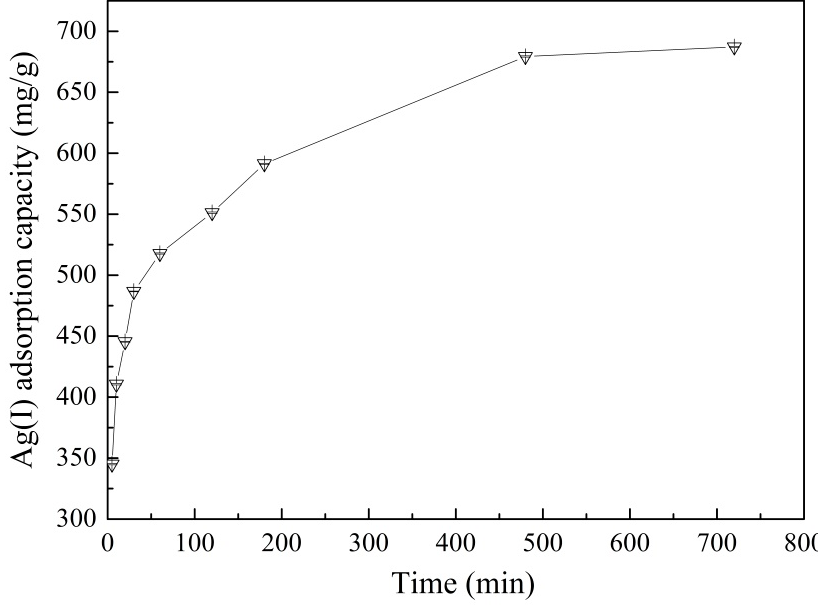
Figure 3. Effect of contact time on the adsorption of Ag + onto TSC-CC resin.